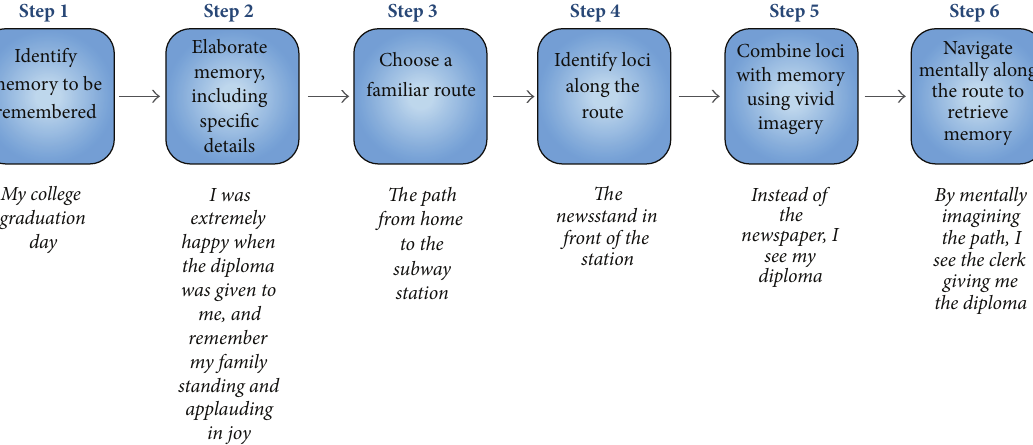
Figure 2: The method-of-loci (MoL). Associating a memory to loci in a familiar route might be used to enhance the retrieval of positive autobiographical memories in